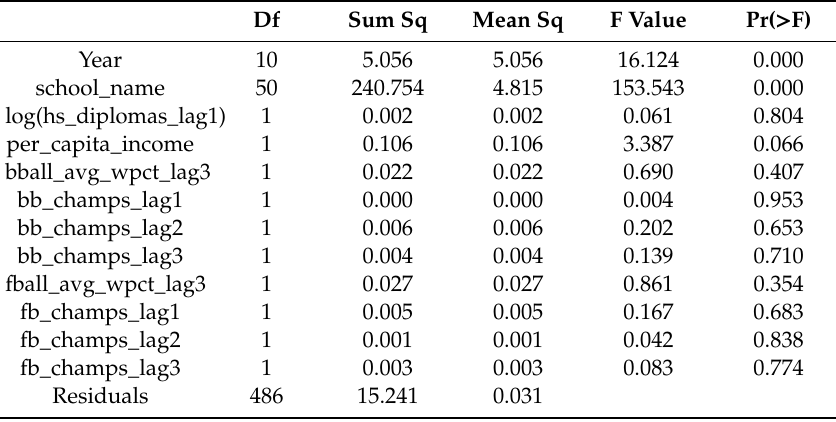
Table A7. ANOVA table for